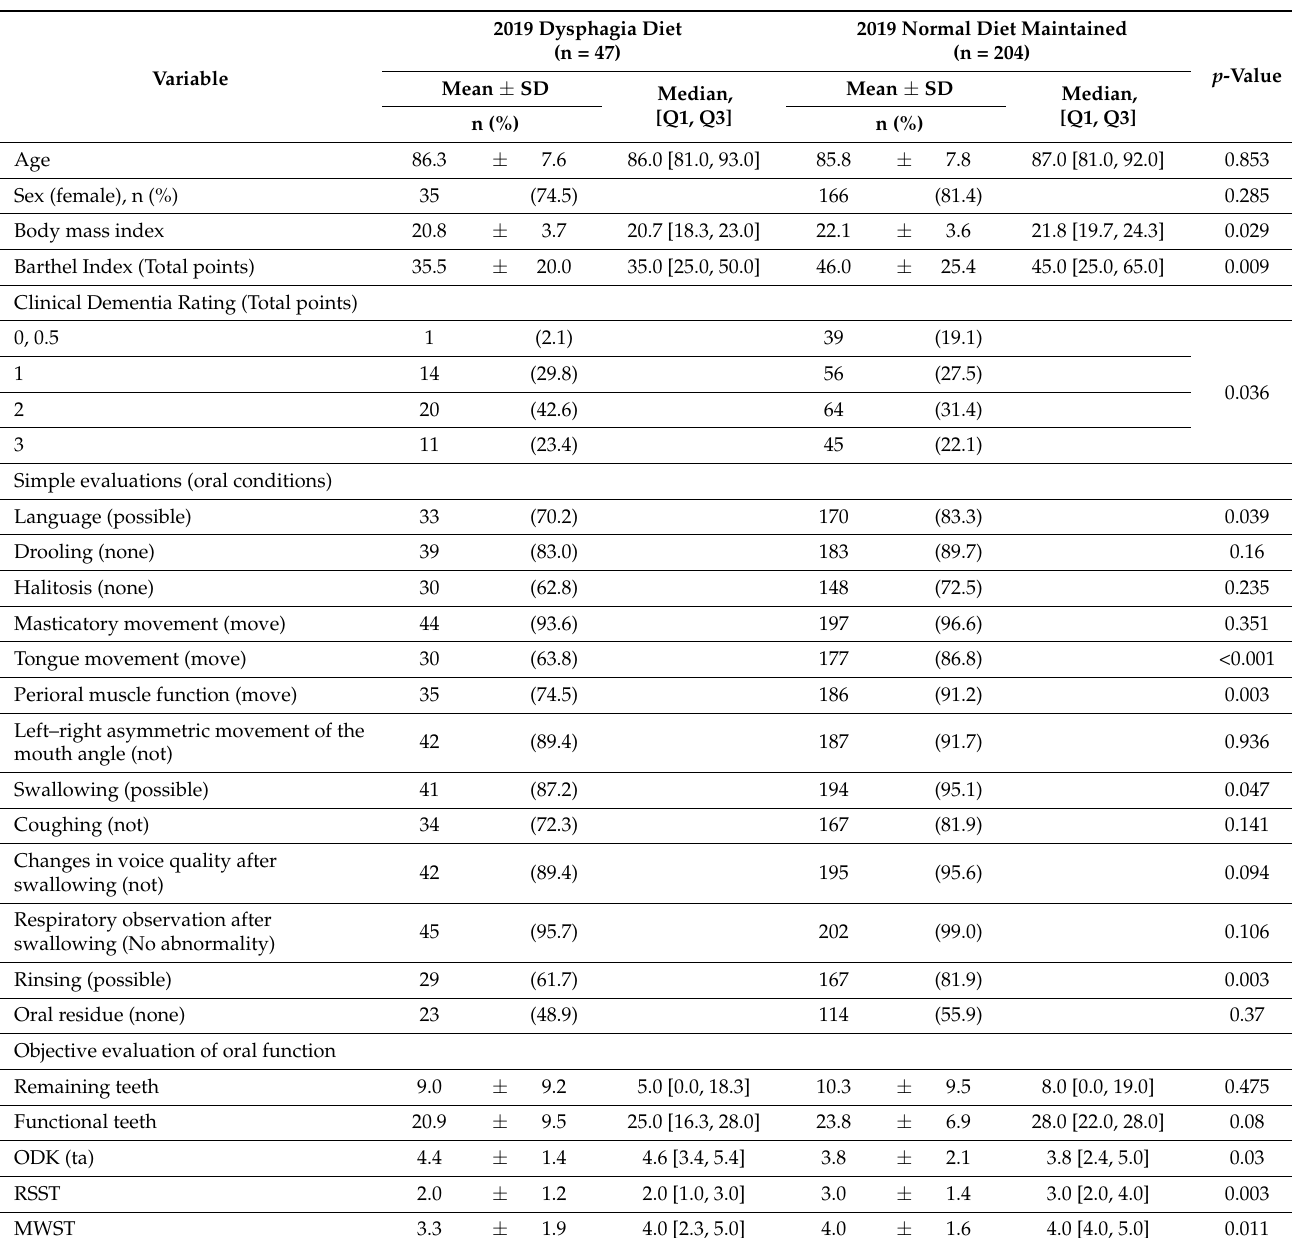
Table 2. Comparison of characteristics of the study participants in the 2019 Normal and Dysphagic Diet